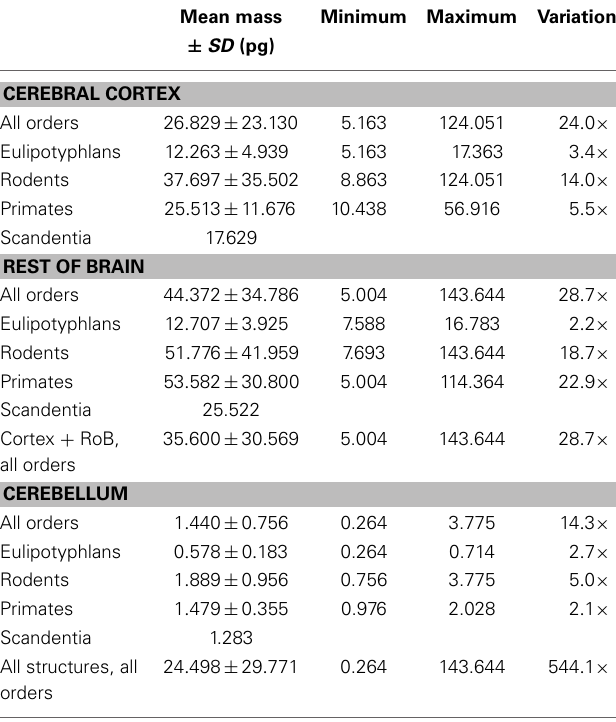
Table 2 | Predicted average neuronal cell mass in mammalian brain